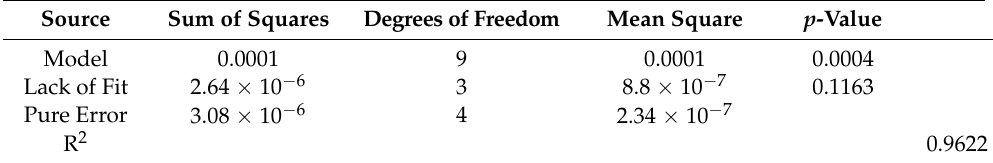
Table 3. ANOVA examination of the experimental response